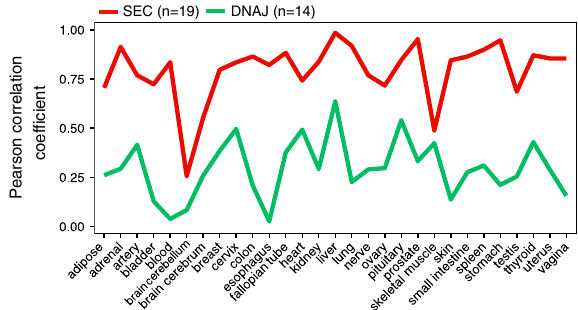
Fig. 3 The correlations of the expression pro fi les from the selected gene families between the pancreas and other tissues. The Pearson correlation scores are shown as X-axis and tissues are located in y -axis. Each dot represents a correlation score of a speci fi c gene family ’ s expression between the pancreas and another tissue. Each example gene family are depicted in different color. The color code for the gene families is located on the right side of the